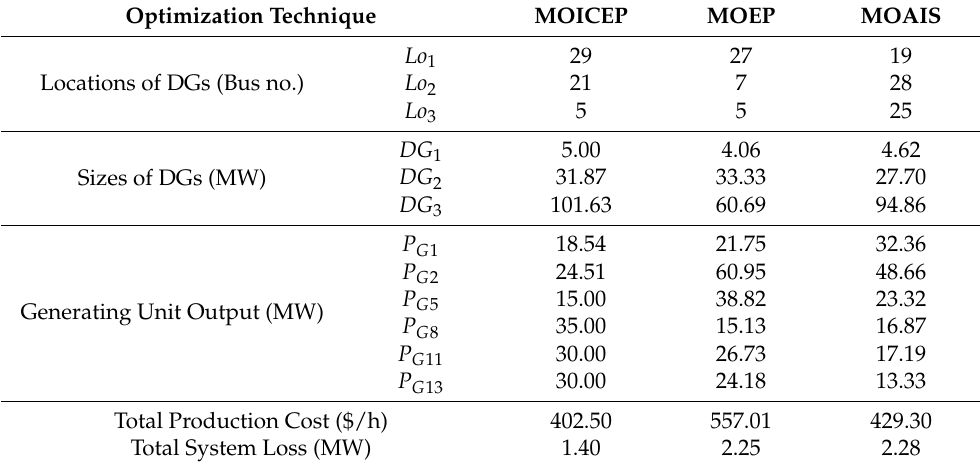
Table 4. Results of the integrated basic ED and DG installation of the IEEE 30-Bus RTS ( w 1 = 0.5 and w 2 = 0.5). Optimization Technique MOICEP MOEP